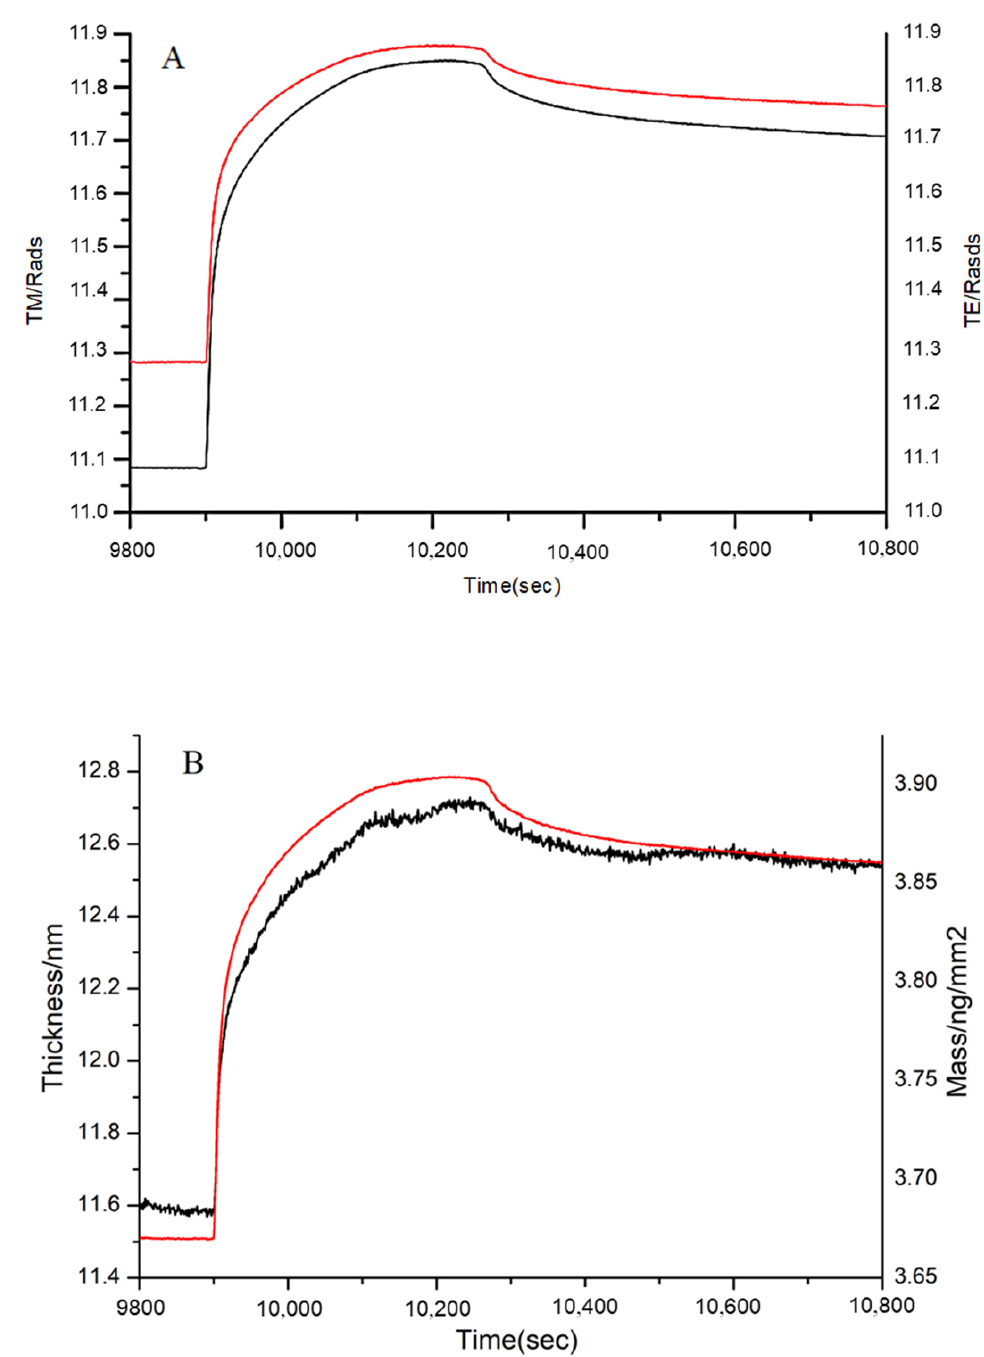
Figure 9. Adsorption of gelatin to immobilized FN on the chip surface as shown by ( A ) the measured TM (black line) and TE (red line) phase changes, and ( B ) the resolved layer thickness (black line) and mass (red line).